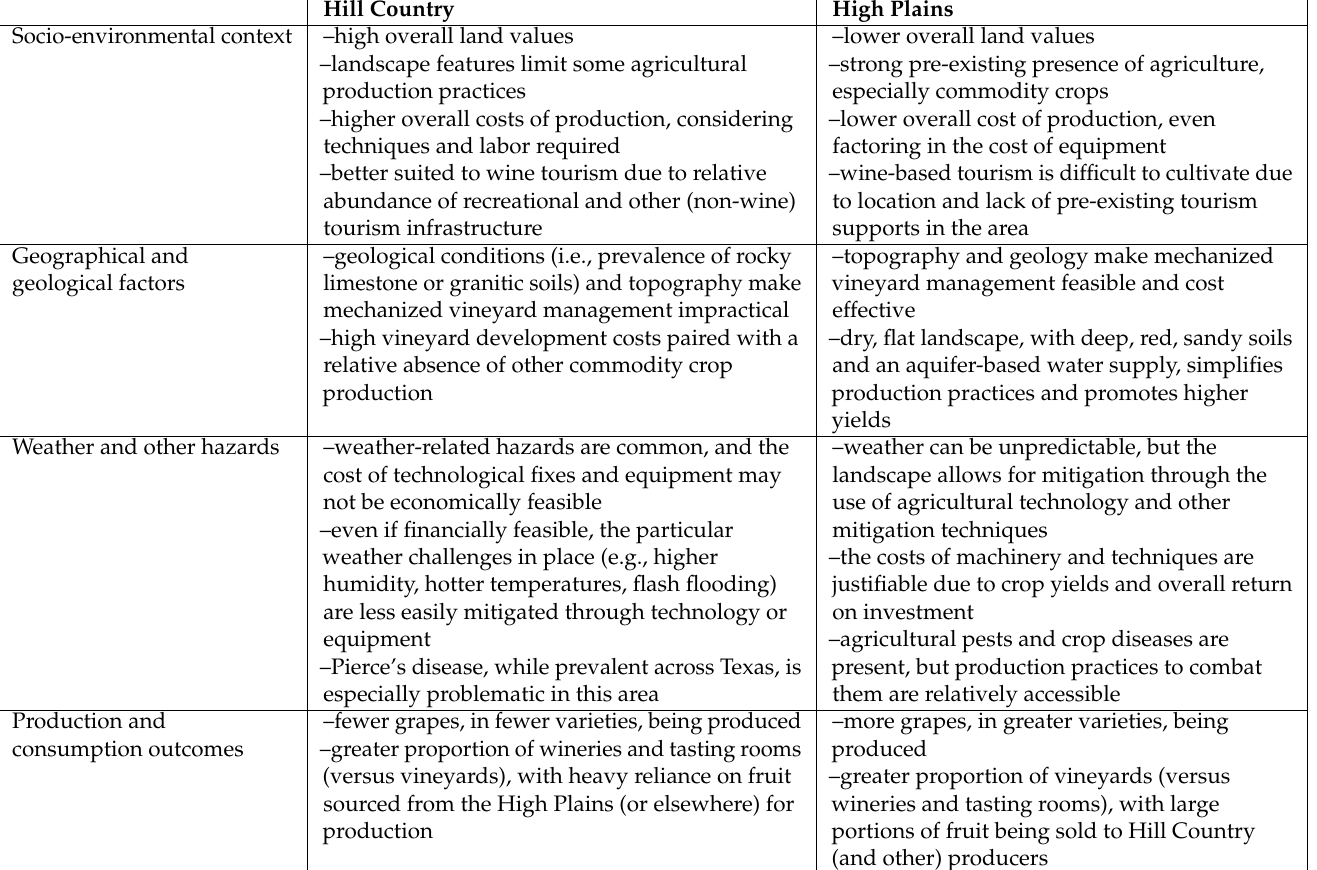
Table 1. Comparison of the Hill Country and High Plains wine landscapes in